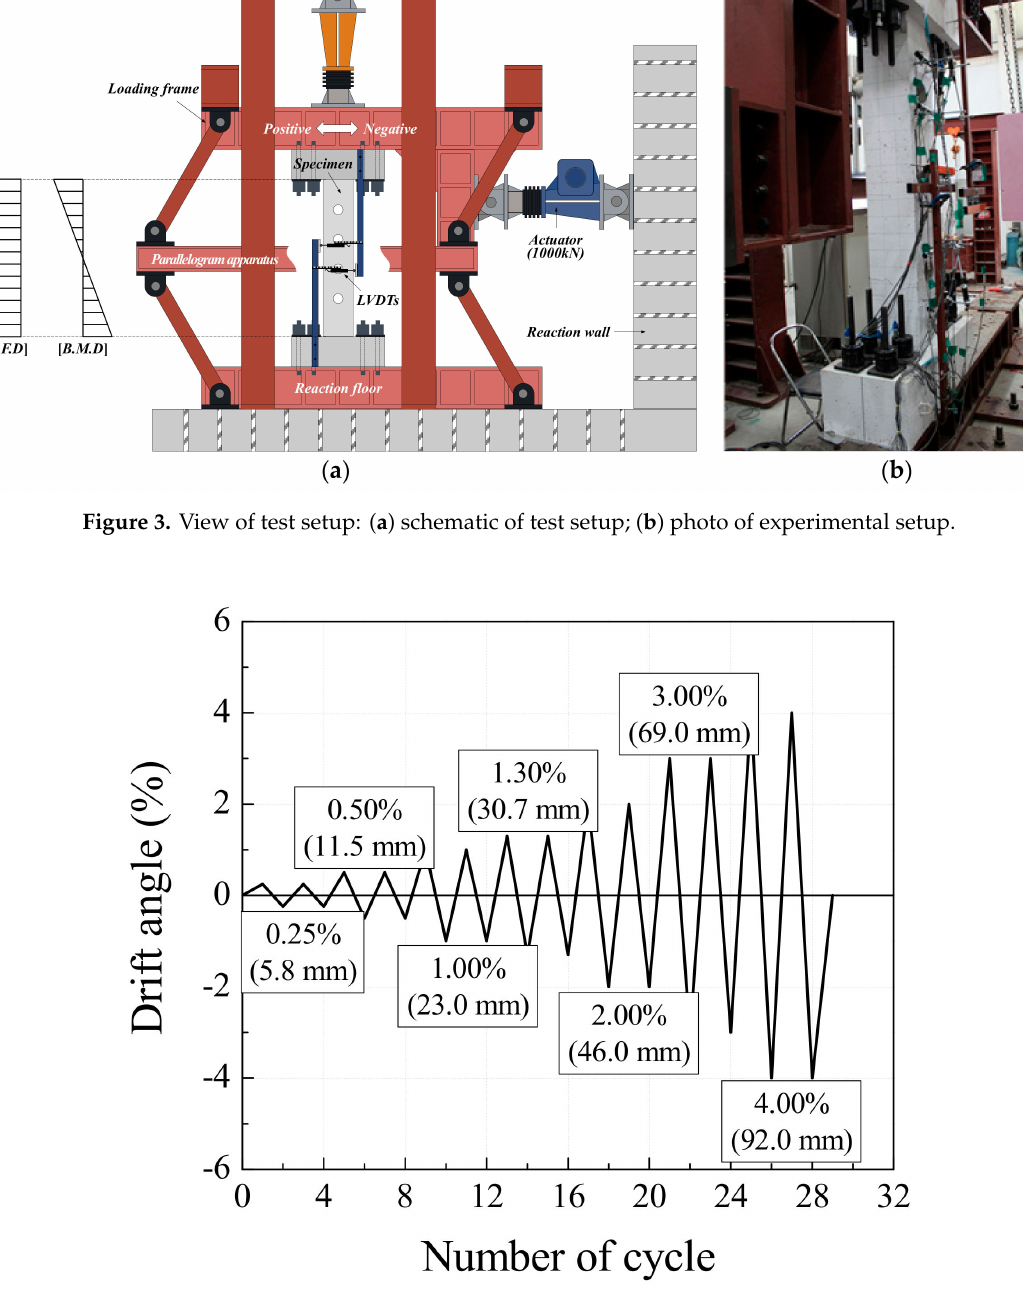
Figure 4. Loading